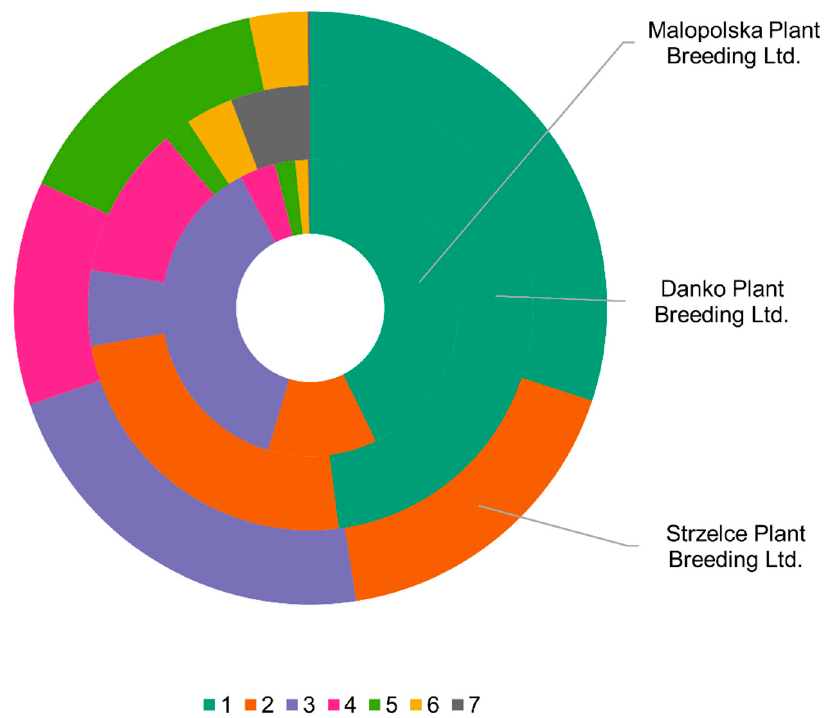
Figure 6. Proportions of seven gene pools in Polish modern cultivars depending on breeding company based on population structure analysis for A. sativa DArTseq SNPs.